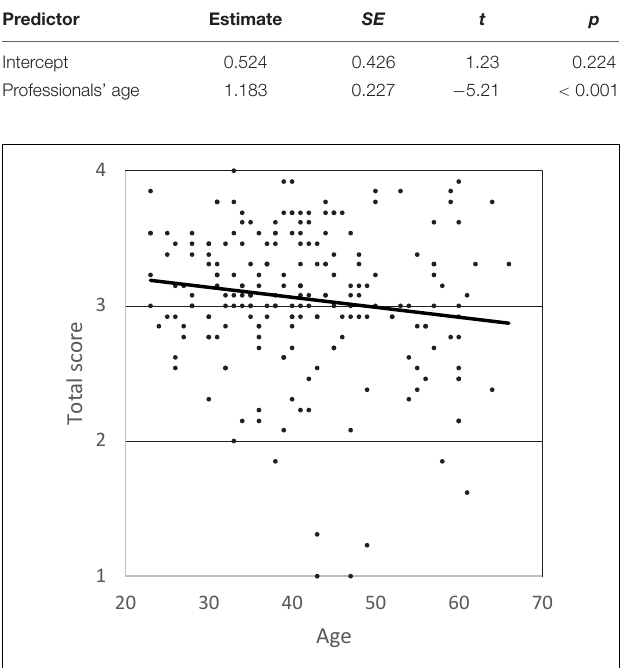
FIGURE 1 | Relationship between professionals’ age and total score on the